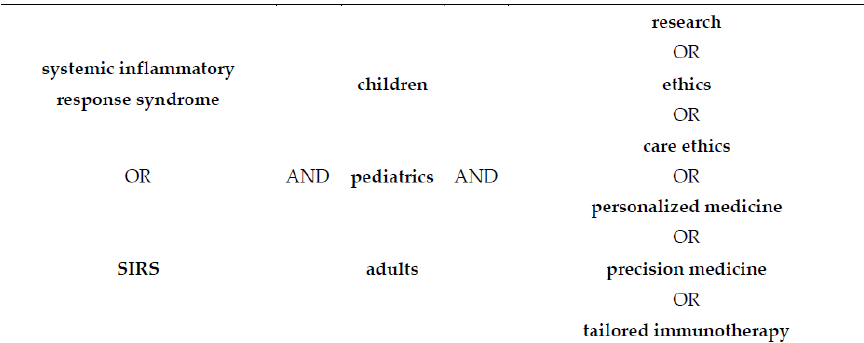
Figure 1. Combination of keywords applied to the systematic literature search.